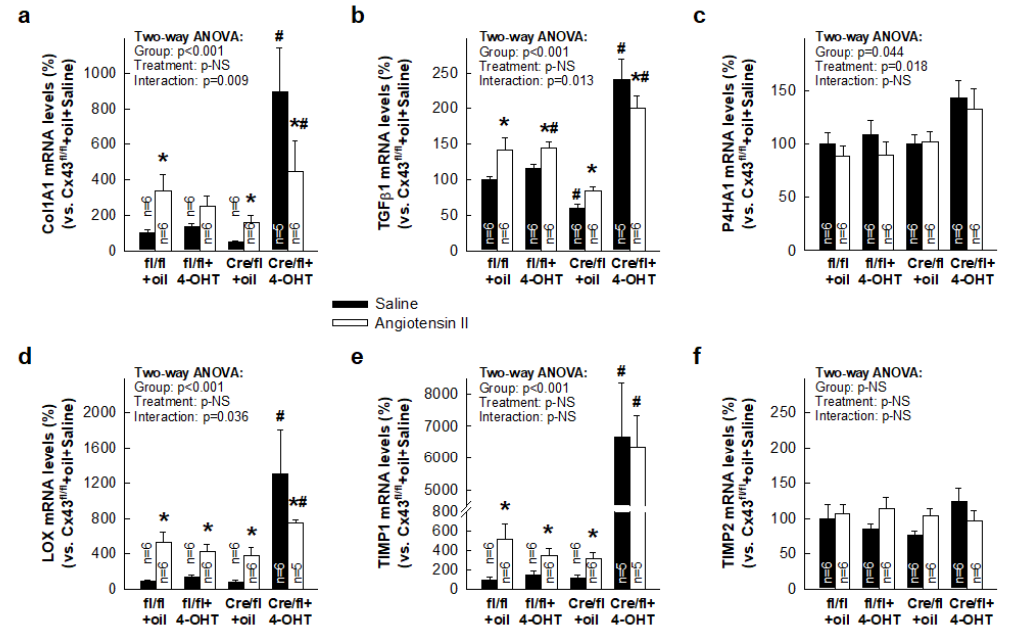
Figure 3. Expression of mRNAs coding for proteins involved in collagen turnover in AngII-treated Cx43 Cre-ER(T)/fl mice. Levels of mRNAs coding for proteins involved in collagen synthesis